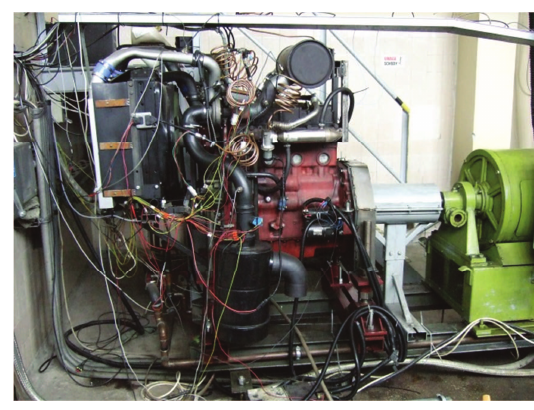
Fig. 1. Research engine mounted at test bench